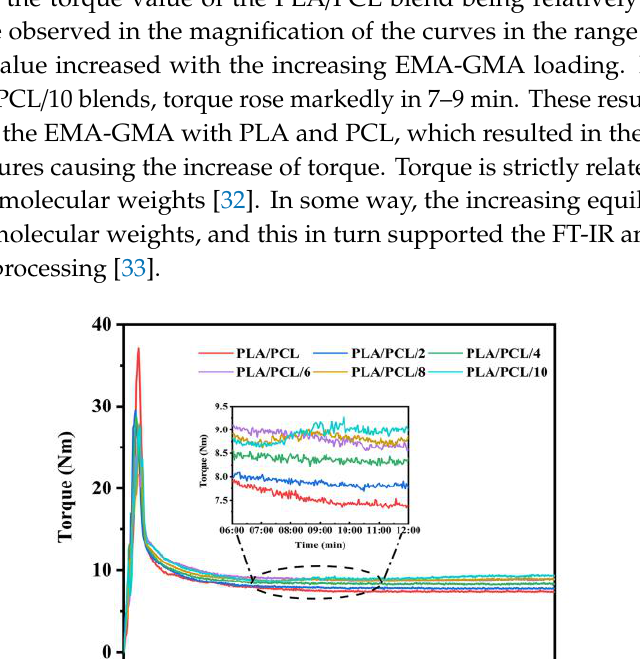
Figure 2. Melt torque during the reactive blending of the PLA/PCL blends with different EMA-GMA additions.